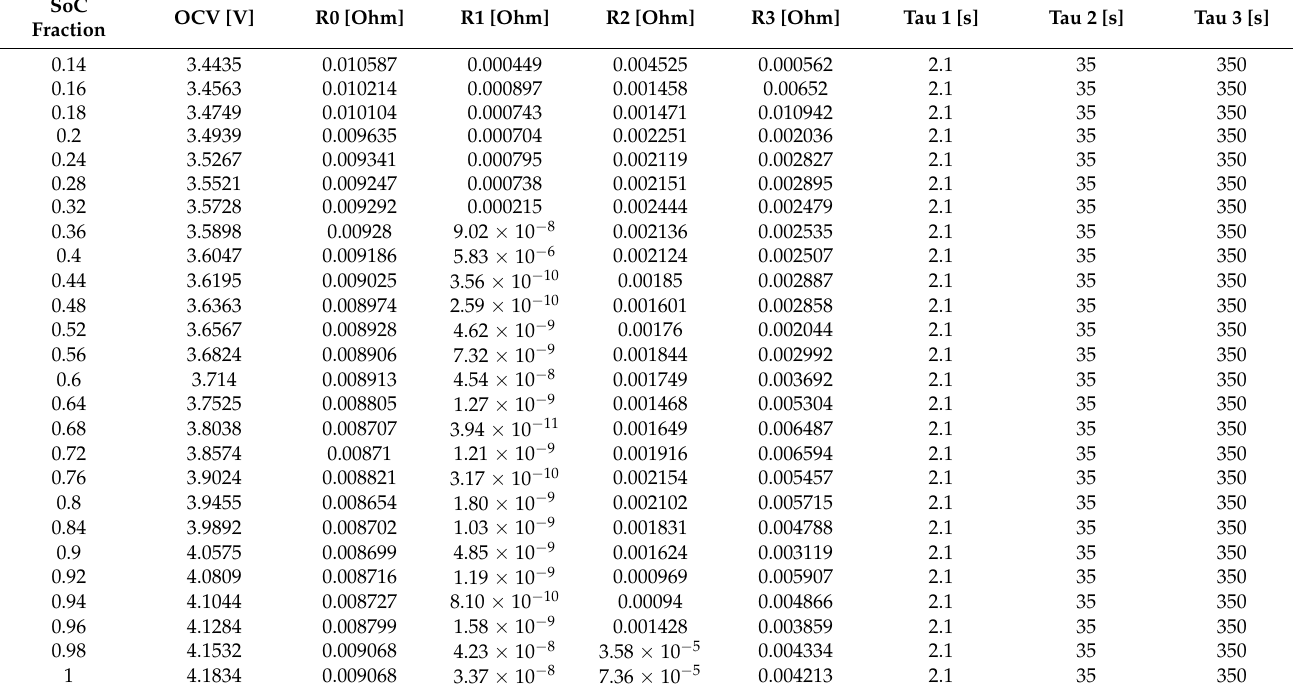
Table A4. ECM results from AMPP in a climate chamber at 25 ◦ C.